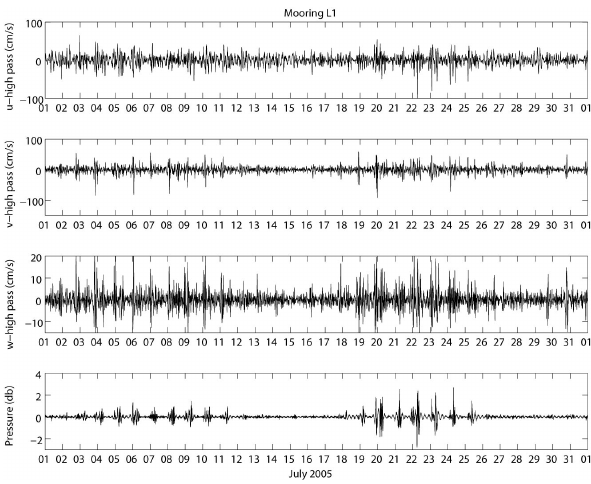
Fig. 13. High-pass filtered pressure fluctuations at moorings S7 (top), B1 (upper middle), B2 (lower middle), and L1 (bottom) for 19–22 August 2005. The distances and travel time between moorings are